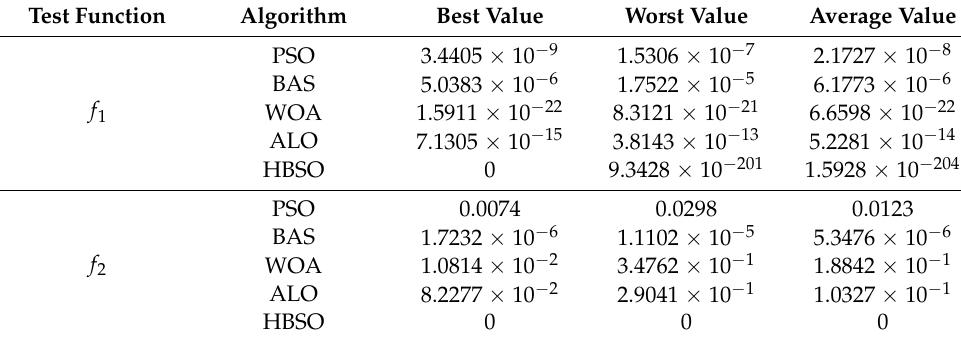
Table 2. Experimental results of 5